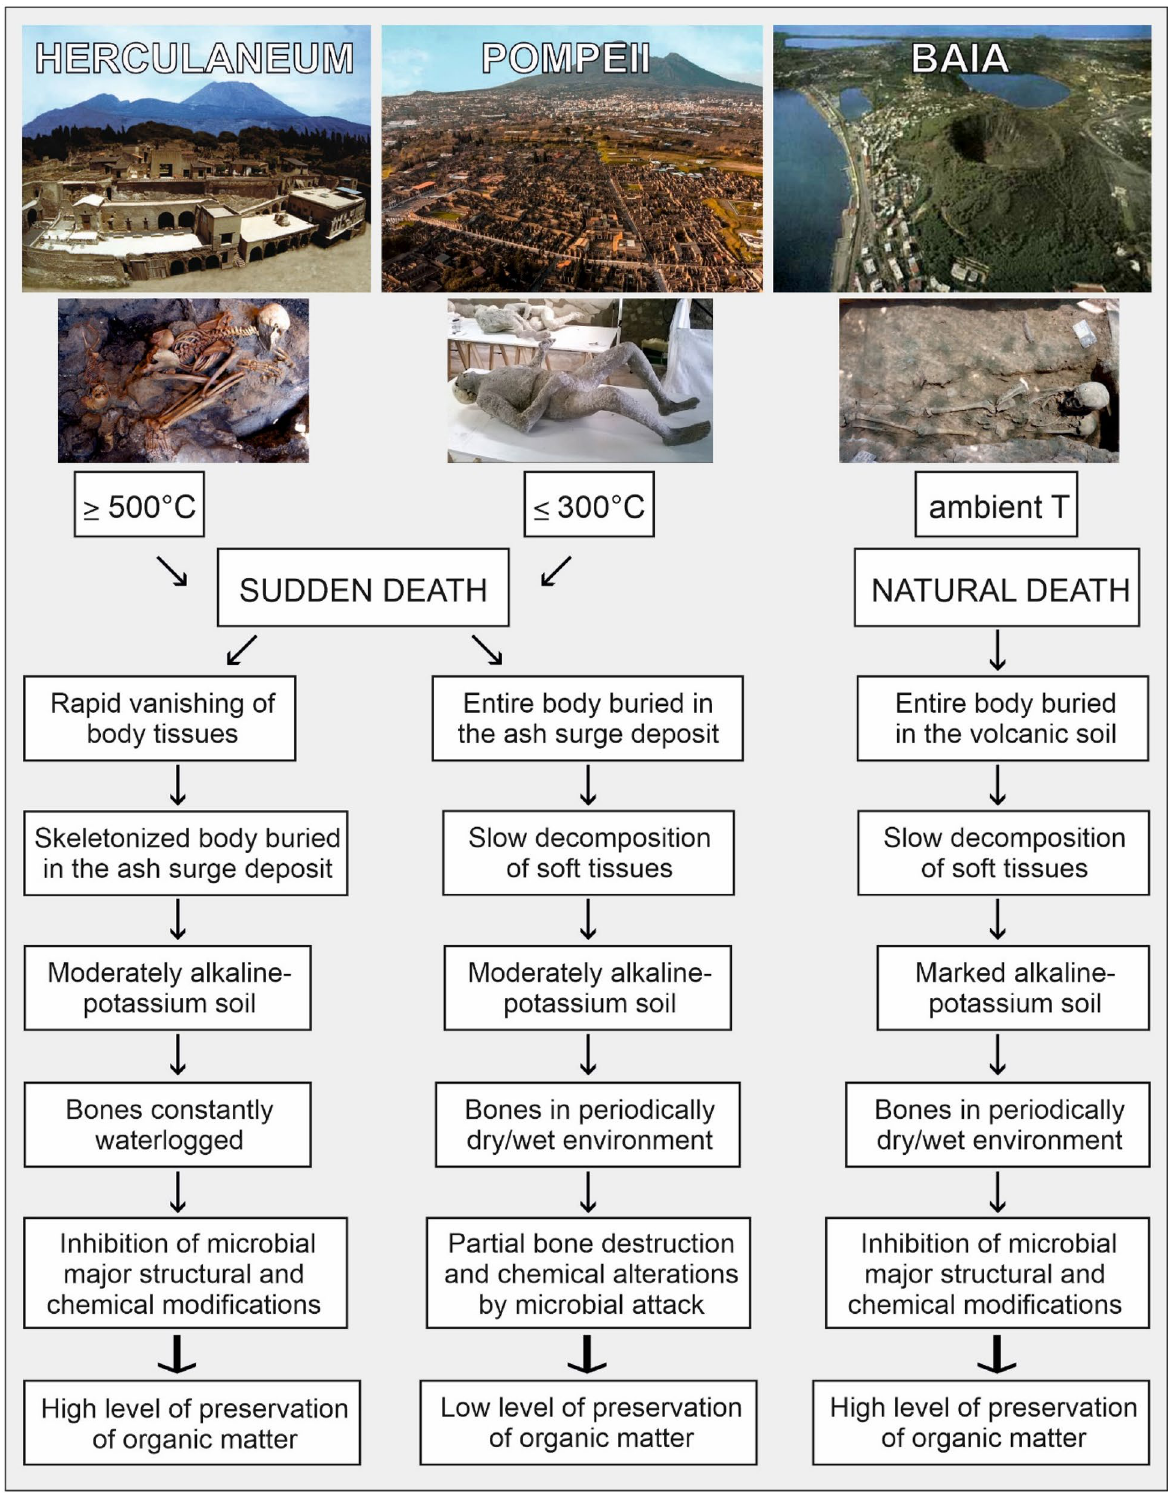
Figure 10. Sequence of biological and taphonomic events concerning the 79 AD human victims from Herculaneum and Pompeii, in comparison with the skeletons from the Baia Scalandrone